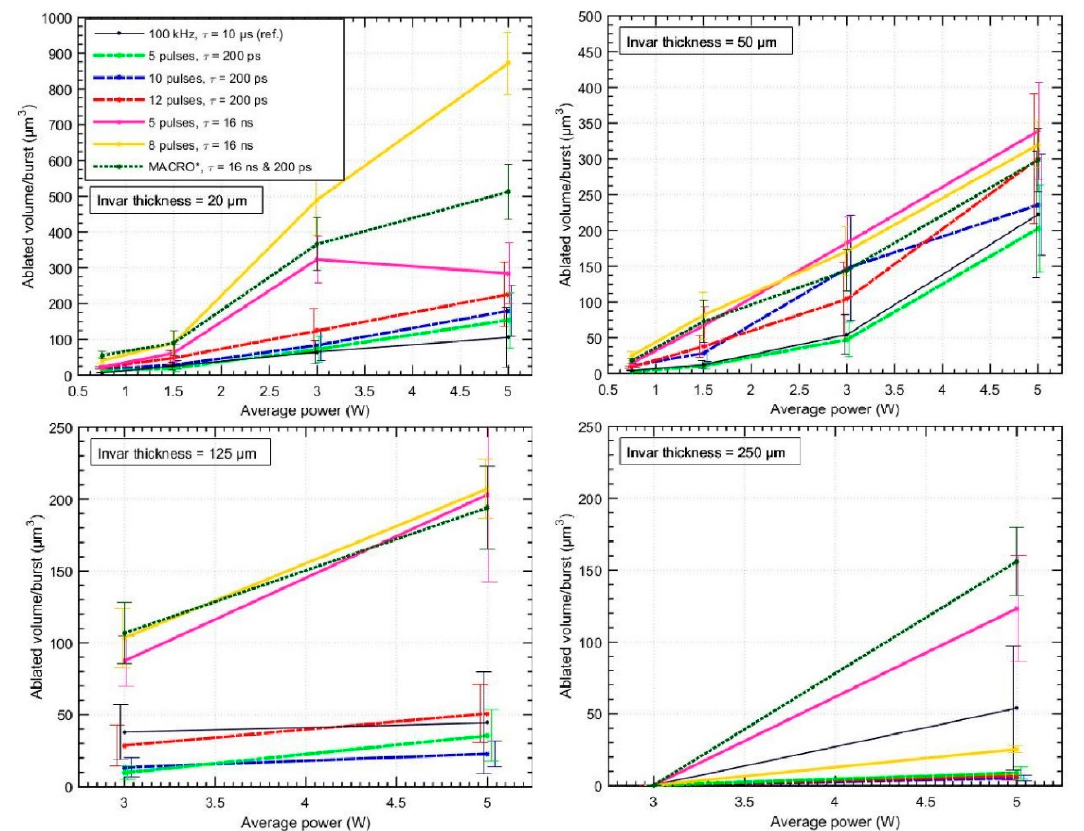
Figure 2. Ablated volume per burst vs. different average laser power. The tests were conducted on 20–250 µm thick Invar sheets varying the different burst modes. The different colors represent different burst modes. The removed volume is measured only for a through-hole that has a ratio between the hole entrance and exit diameter of at least two. Note the change in y -axis scale in the results. The results indicate that higher ablated volume per burst values are achieved for thinner